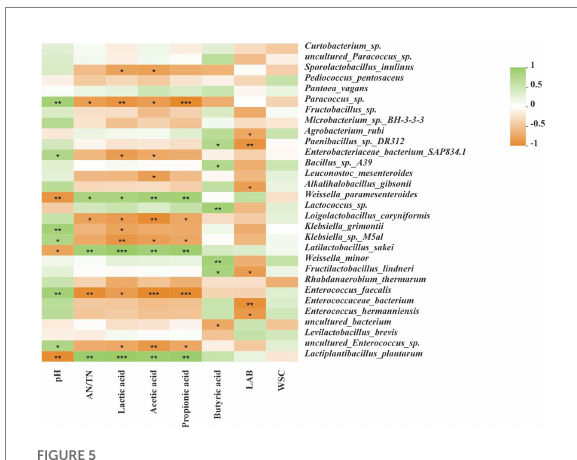
FIGURE 5 Correlation analyses between bacterial community and terminal fermentation products at species level. Fermentation characteristics are displayed horizontally and the bacterial community information is displayed vertically. The corresponding value of the middle heat map is the Spearman correlation coefficient r, which ranges between − 1 and 1; r < 0 indicates a negative correlation (orange), r > 0 indicates a positive correction (green), and “ * ,” “ ** ,” and “ *** ” represent p < 0.05, p < 0.01, and p < 0.001, respectively. AN/TN, ammonia nitrogen/total nitrogen; LAB, lactic acid bacteria; WSC, water-soluble